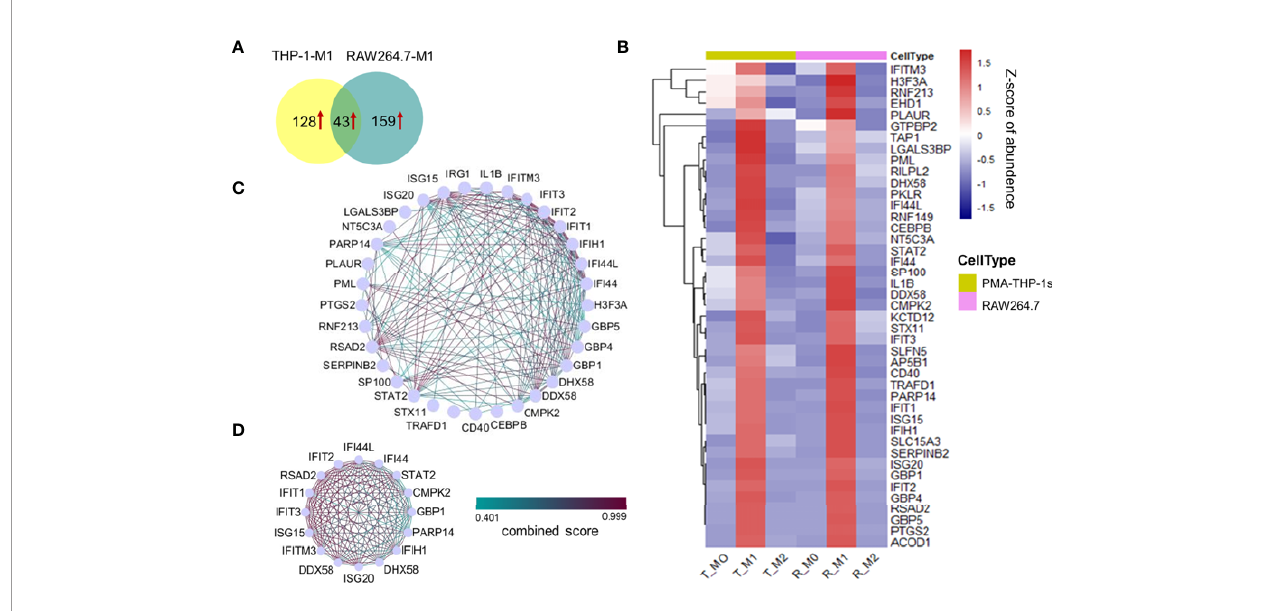
FIGURE 4 | Proteins uniquely up-regulated in M1 macrophages from both the human THP-1 and mouse RAW264.7 cell lines. (A) Venn diagram showing 43 uniquely up-regulated proteins in M1 macrophages for both human THP-1 and mouse RAW264.7 cells. (B) Cluster analysis of 43 up-regulated proteins in M1 macrophages with z-scored of protein abundance among three phenotypes from two cell lines. (C) PPI network of highly interconnected proteins among 43 up- regulated proteins in M1 macrophages. (D) A module was extracted by MCODE with score = 15.333.